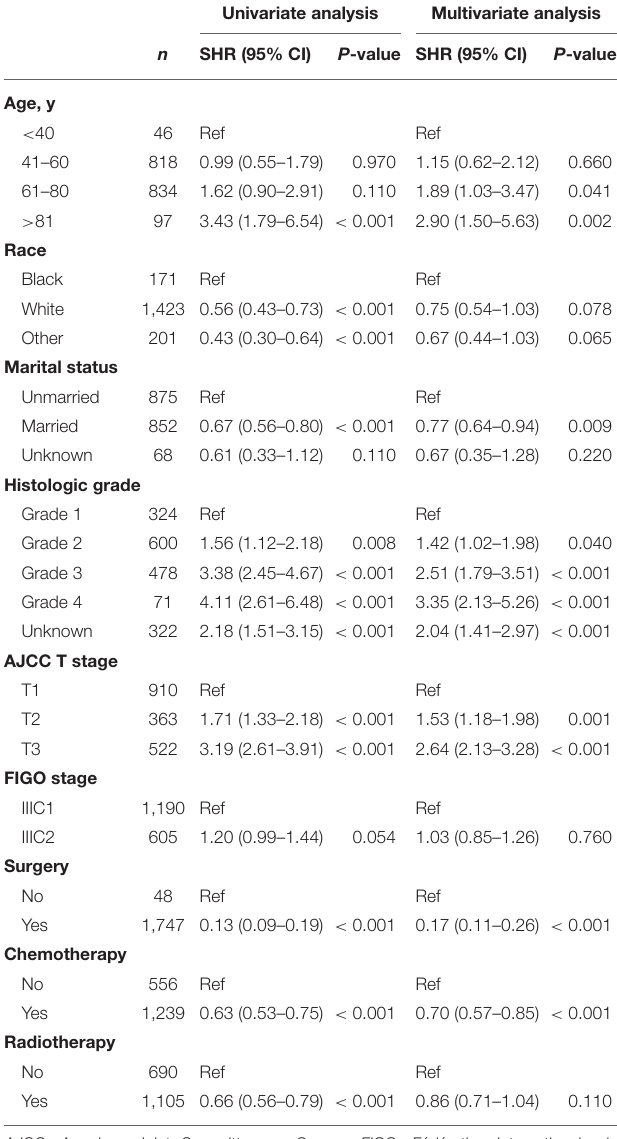
TABLE 1 | Univariate and multivariate analyses of cancer-specific mortality in the training set: a competing risk regression model. Univariate analysis Multivariate analysis